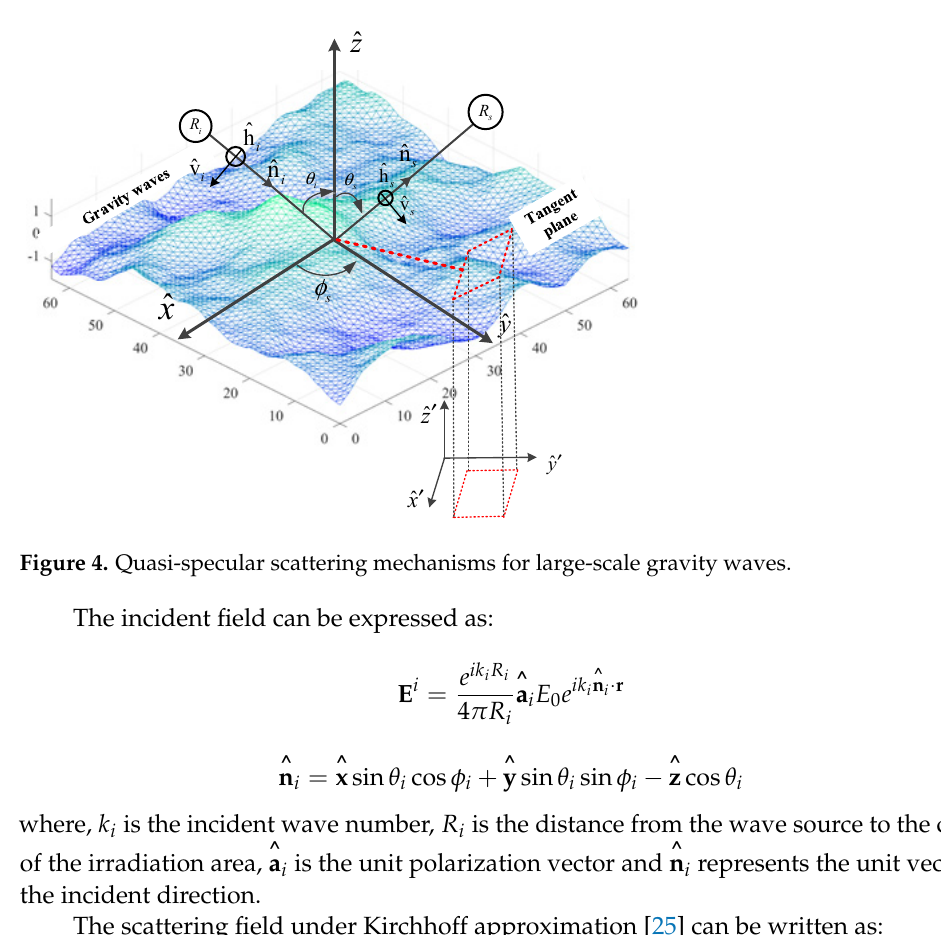
x Figure 3. EM scattering mechanism of radar-illuminated sea surface.